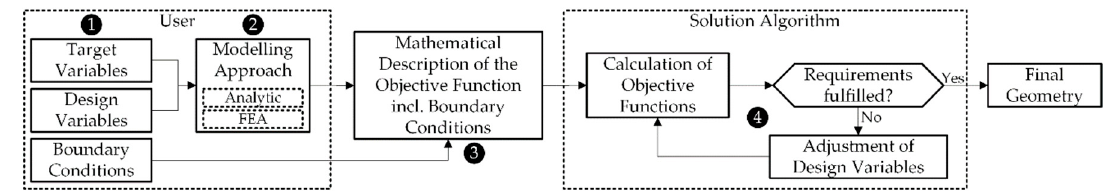
Figure 1. Deterministic method with physical model. Distinct properties are numbered and detailed.